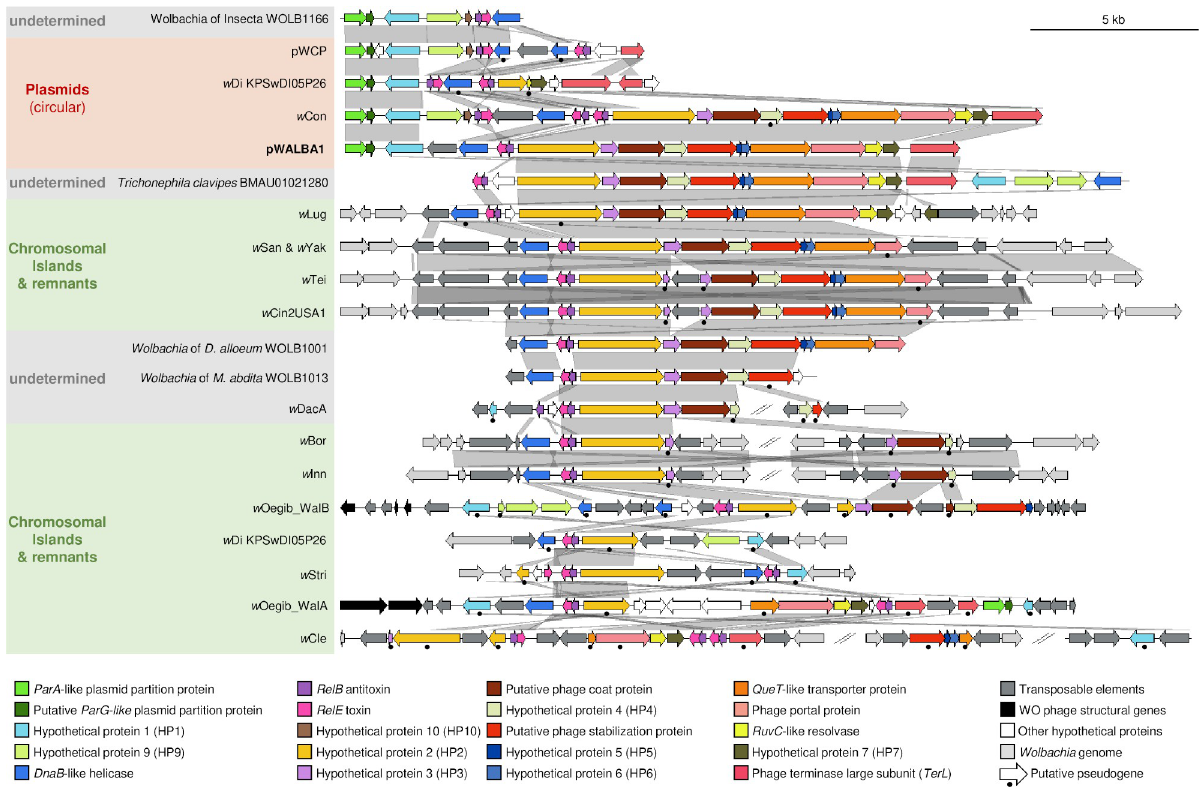
Fig 4. Gene organisation and comparison of pWALBA1-like sequences. Similarity is indicated by gene colours (TBLASTN) and by the grey areas between sequences (BLASTN) where darker grey means more similar.